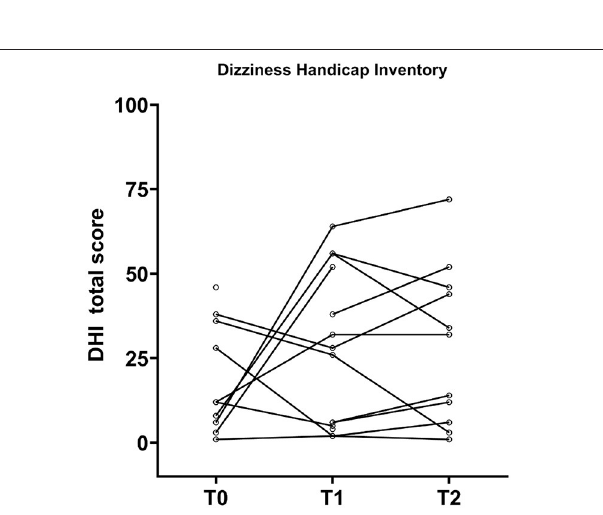
FIGURE 7 | Patient-reported vestibular outcomes measured by the dizziness handicap inventory (DHI) before and after implantation ( n = 35). No significant change in total score were reported between pre- and postimplantation. Eighteen patients with both pre- and postoperative DHI 0 are not visualized on the plot. T0, baseline before implantation; T1, first postoperative follow-up; T2, second postoperative